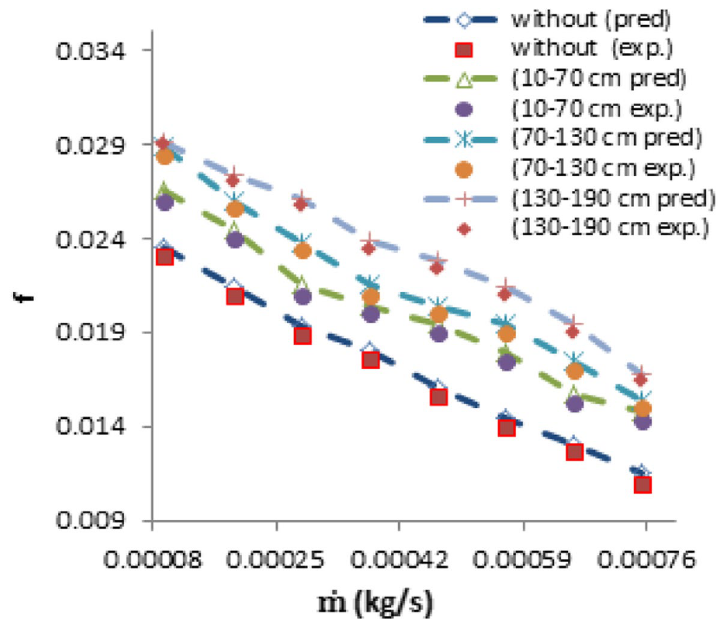
Fig. 12 ANN predicted and experimental friction factor with and without bumpers